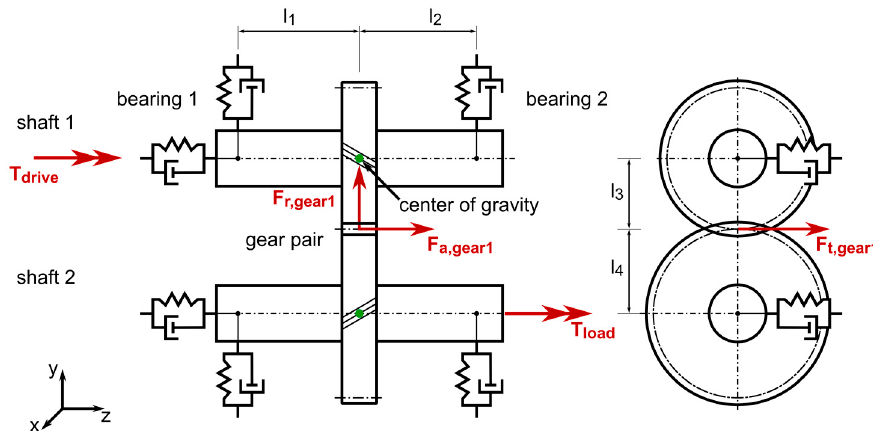
Figure 4. Gear system.